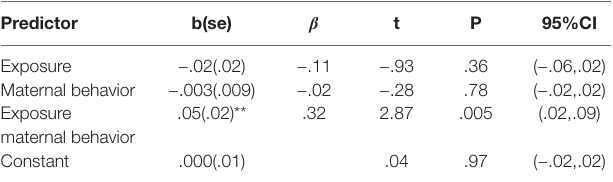
TABLE 1 | The moderation effect of exposure and maternal empathic behavior on maternal SM-AI.